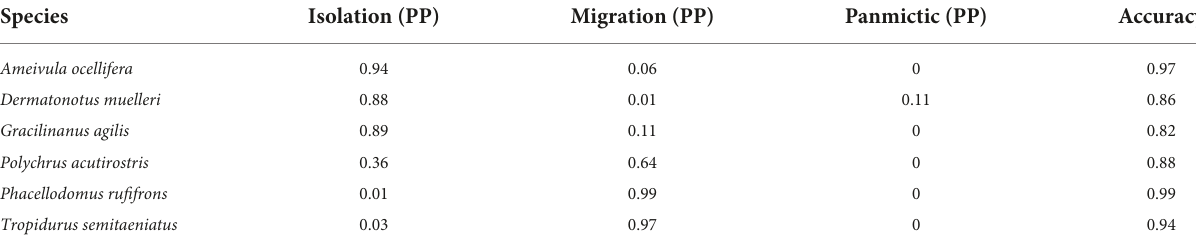
TABLE 5 Posterior probabilities for each model and study species from supervised machine learning (SML). Species Isolation